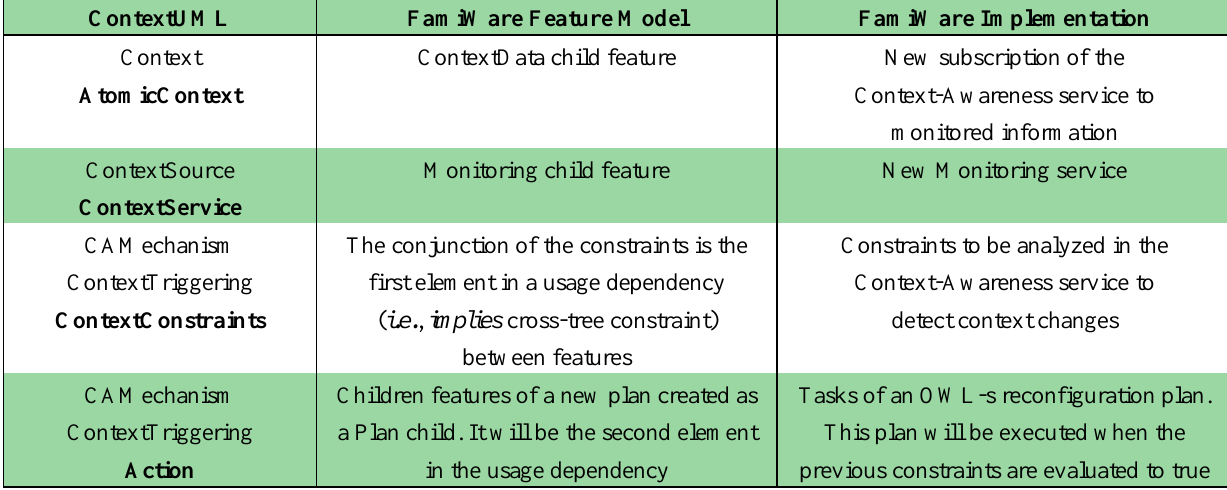
Table 1. Correspondences of ContextUML with FamiWare feature model and